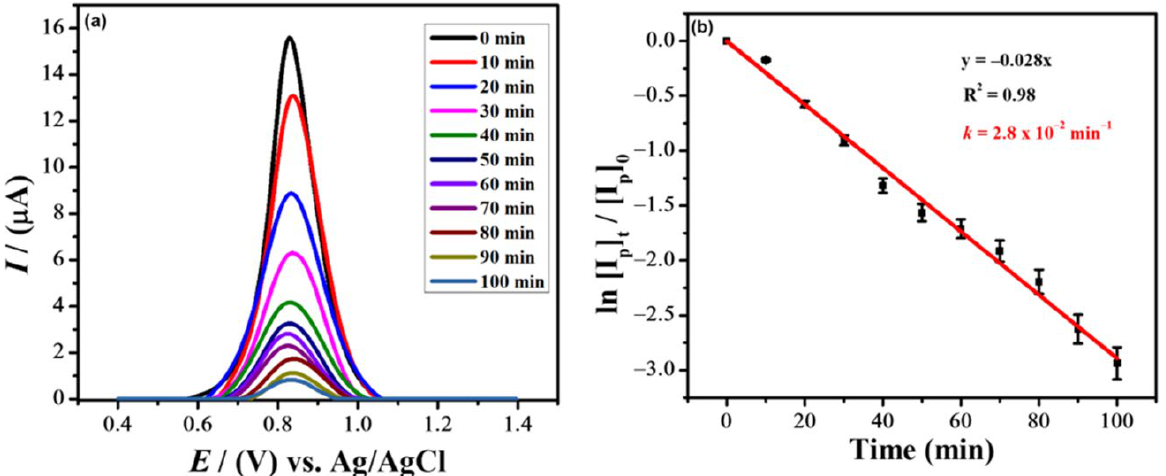
Figure 8. ( a ) The SWV of NBS at different time intervals recorded by using COOH- f MWCNTs/GCE under optimized conditions. ( b ) Effect of irradiation time on NBS photocatalytic degradation under direct